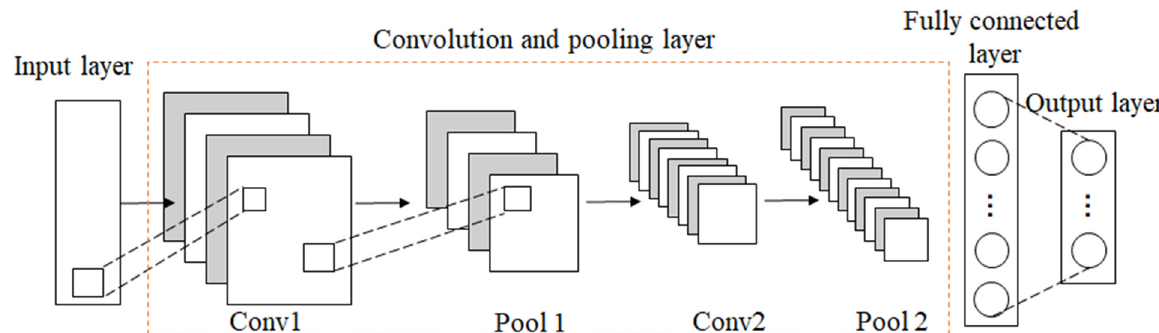
Figure 3. The architecture of CNN.